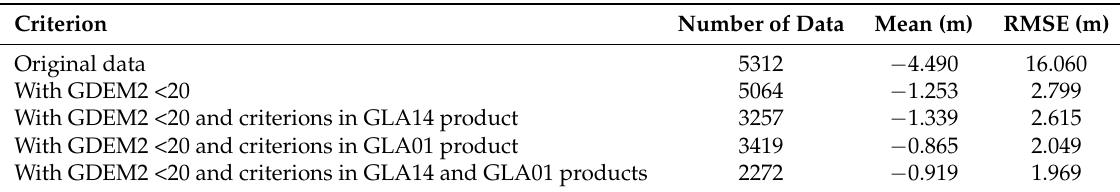
Figure 9. Evaluation of the GLAS footprint extraction with the proposed criterion. The GLAS footprints are marked with red points. Table 9. GLAS footprint extraction with the proposed